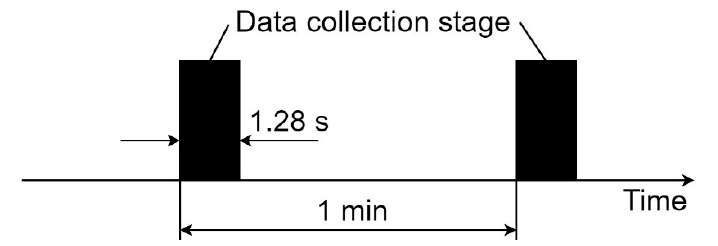
Figure 8. Sampling settings for vibration signals.